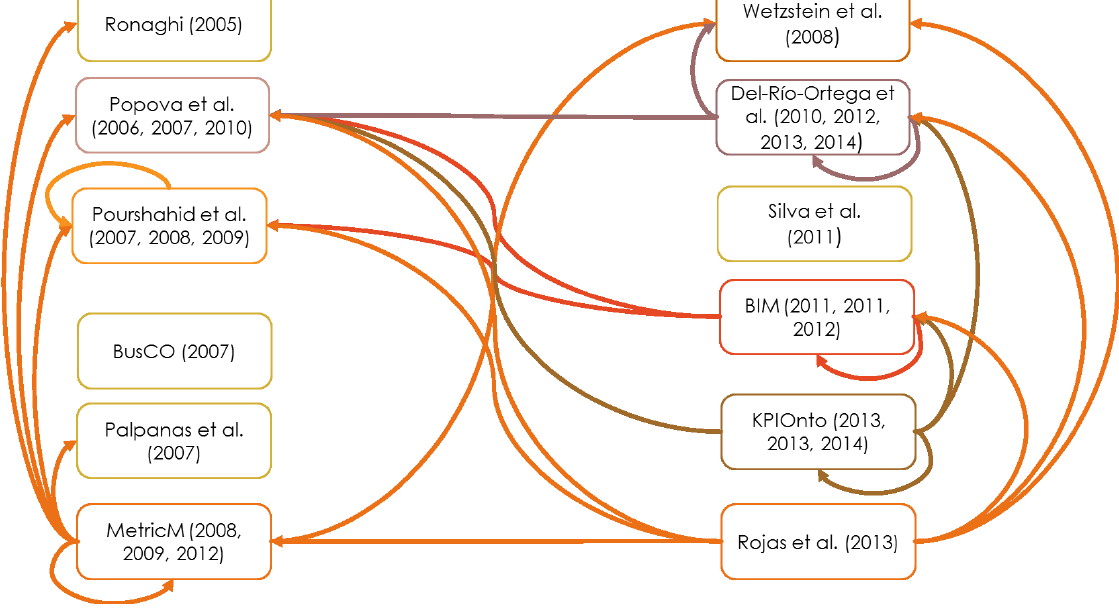
Figure 4. Citations between selected